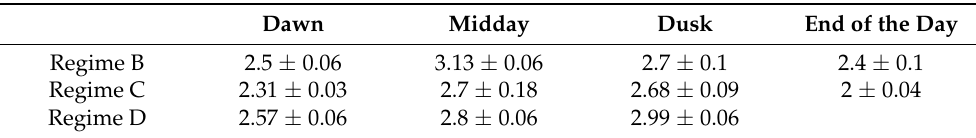
Figure 6. Evolution of cells number under different cultivation regimes: ( A ): Light fluctuation (Regime C); ( B ): Temperature fluctuation (Regime B); ( C ): Light and temperature fluctuations (Regime D). Only Trial 1 is shown in Figure 6c—similar results for other trials. Table 1. Variation of N . sp. QU130 cell diameter (in µ m) over the day and under different cultivation regimes: Regime B: Temperature fluctuation; Regime C: Light fluctuation; Regime D: Light and temperature